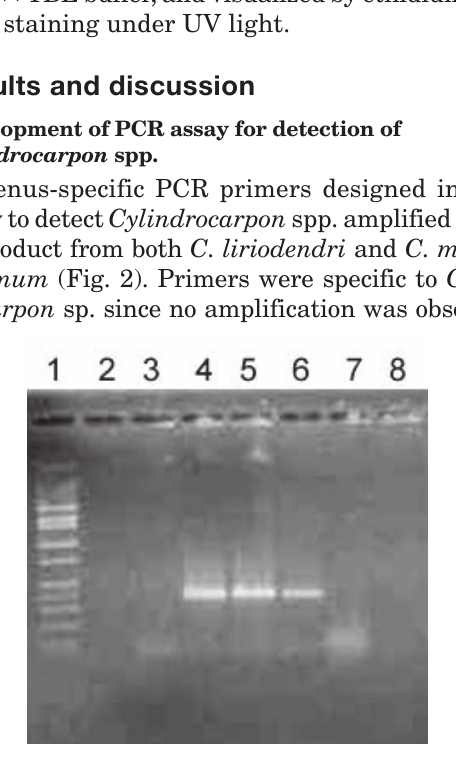
Fig. 2. PCR detection of Cylindrocarpon spp. using ge- nus-specific primers. Lane 1, 100 bp DNA ladder; 2, no DNA; 3, healthy grapevine; 4, Cylindrocarpon macrodi- dymum DNA; 5, C. liriodendri DNA; 6, C. macrodidy- mum -infected grapevine plant; 7, Phaeomoniella chlamy- dospora DNA; 8, Phaeoacremonium aleophilum